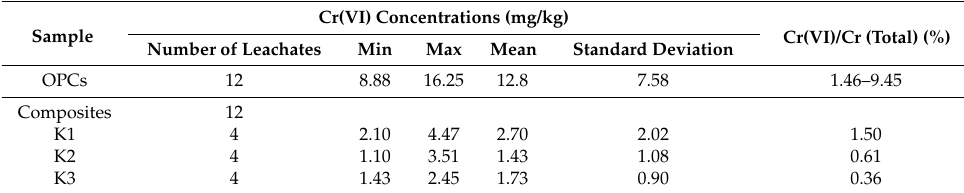
Table 4. Cr(VI) amounts dissolved by